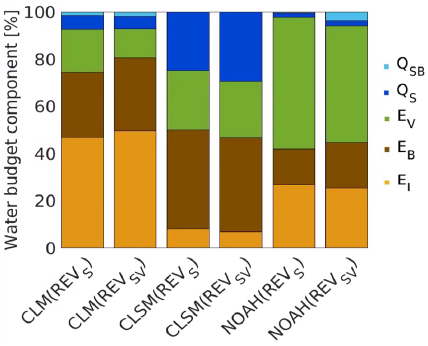
Figure 5. Annual water budget components for the period 2007– 2015 relative to the total precipitation for the 197px defor- ested between 2002 and 2006 for REV S and REV SV simulations ( Q SB : subsurface runoff, Q S : surface runoff, E V : vegetation tran- spiration, E B : bare soil evaporation, E I : interception